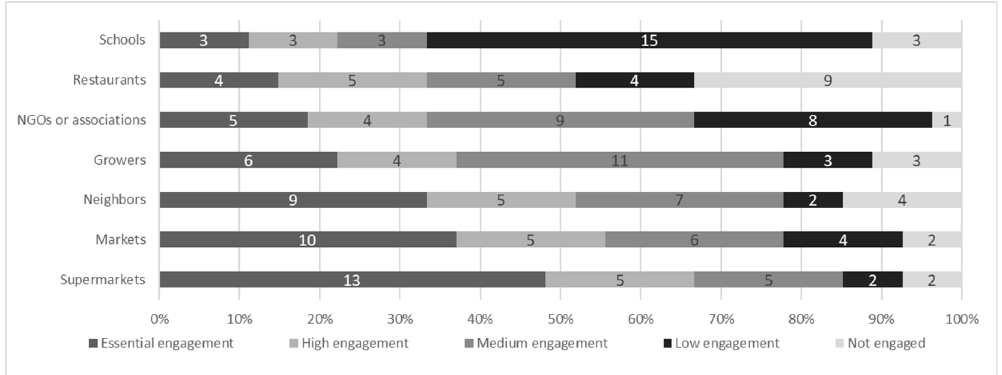
Figure 11. Levels of engagement of different potential stakeholders.